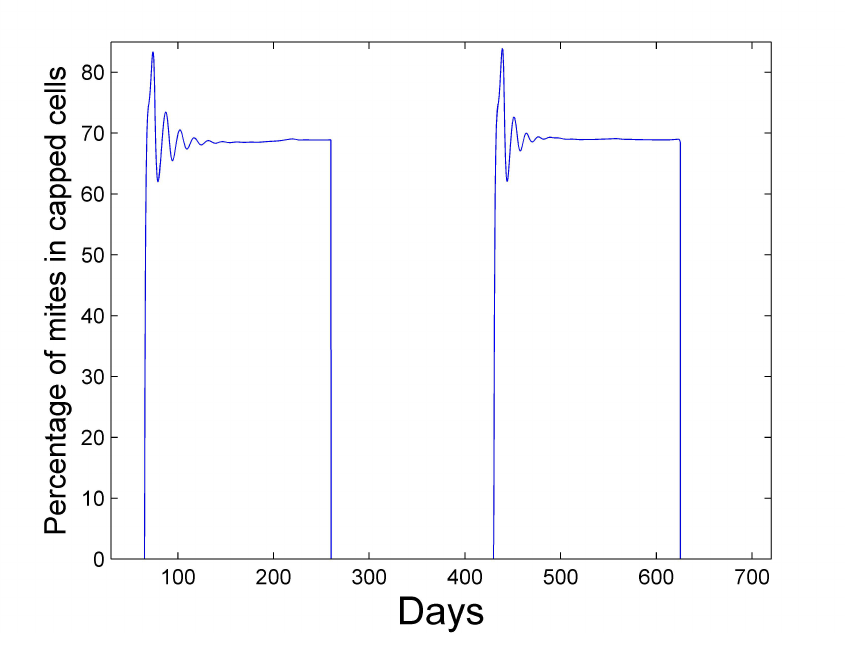
Figure 5. Percentage of mites in capped cells during summer season. Table 4. Simulation parameters.